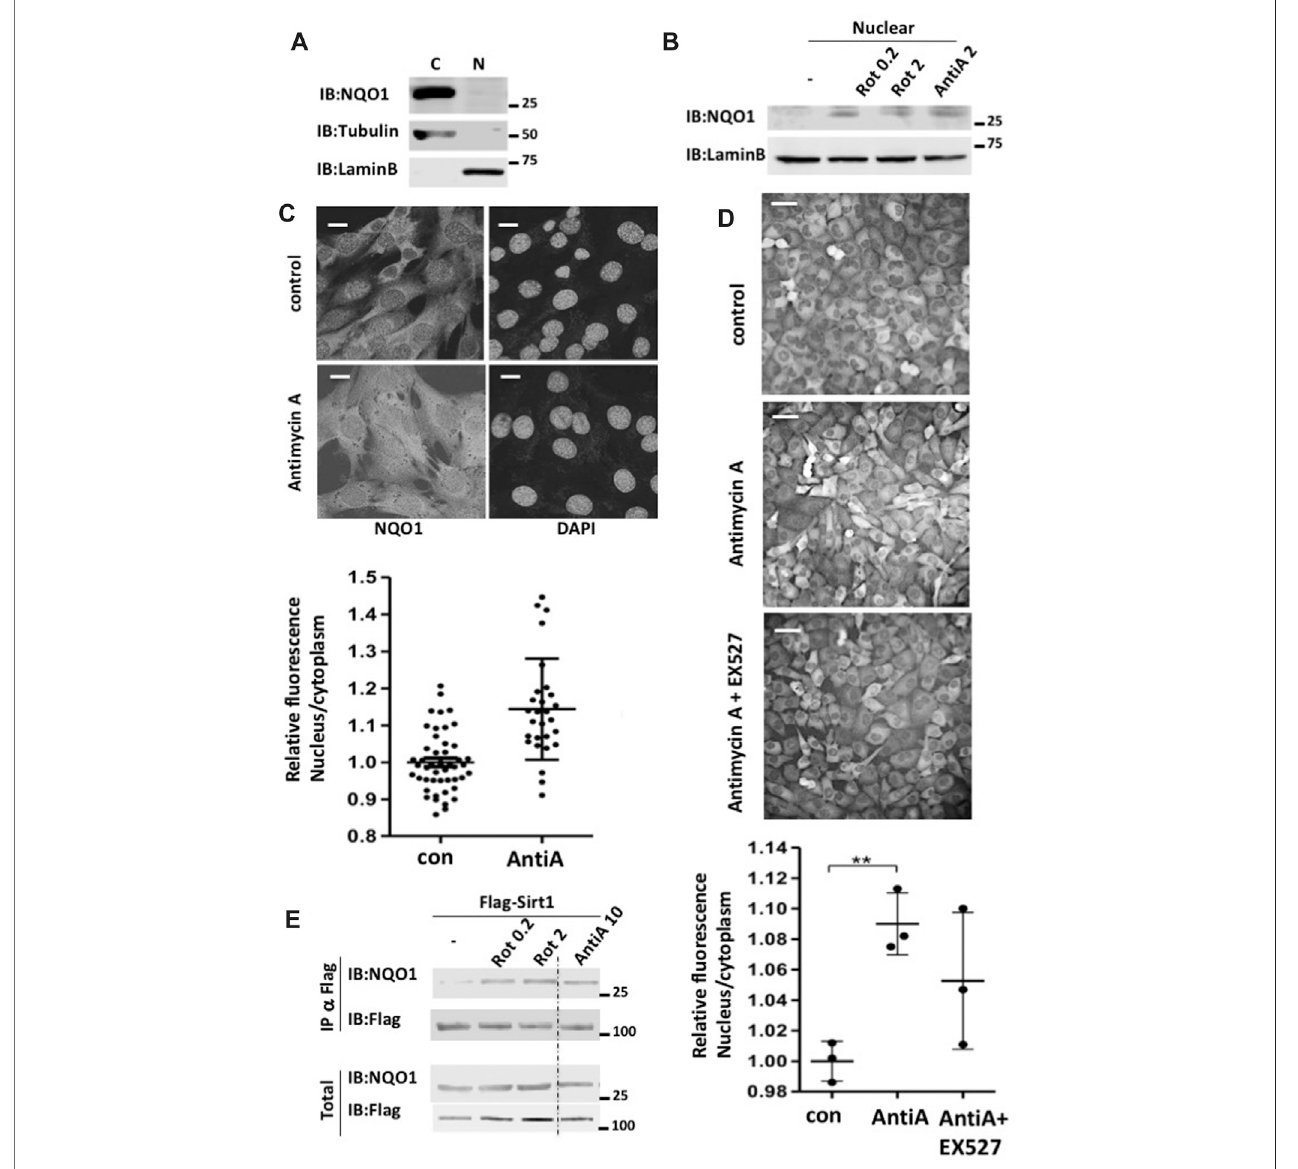
FIGURE4| MitochondrialinhibitionincreasesnuclearNQO1levelanditsSIRT1association. (A) cytoplasmatic(C)andnuclear(N)NQO1distributionwereanalyzed inNIH3T3cells. (B) ThenuclearfractionofNQO1wasanalyzedinNIH3T3cellsfollowingtreatment withindicatedconcentrationsofrotenoneorantimycinAfor16 h. (C) Subcellular distribution of NQO1 under conditions of mitochondrial inhibition. C2C12 cells were antimycin A treated (10 μ M for 16 h) and fi xed for immuno fl uorescence analysiswiththeNQO1antibody(Epitomics2618-1).NuclearstainingisindicatedbyDAPI.Thequanti fi cationofthenuclear/cytoplasmratiobasedon fl uorescence intensity is shown (lower panel). Scale bar: 10 μ m (D) H1299 cells in which the endogenous NQO1 gene contains YFP in the second exon (clone 130207p11G9) were antimycin A treated in the presence or absence of EX527 (25 μ M), a speci fi c Sirt1 inhibitor. The quanti fi cation of the nuclear/cytoplasm ratio based on fl uorescence intensity measured of three independent fi eld is shown (lower panel). Scale bar: 50 μ m E) HEK293T cells over expressing Flag-SIRT1 and NQO1 were treated with indicated concentrations of rotenone or antimycin A for 16 h. Following the treatment the nuclear fraction was isolated and the association of NQO1 to SIRT1 in the nucleus was analyzed by fl ag